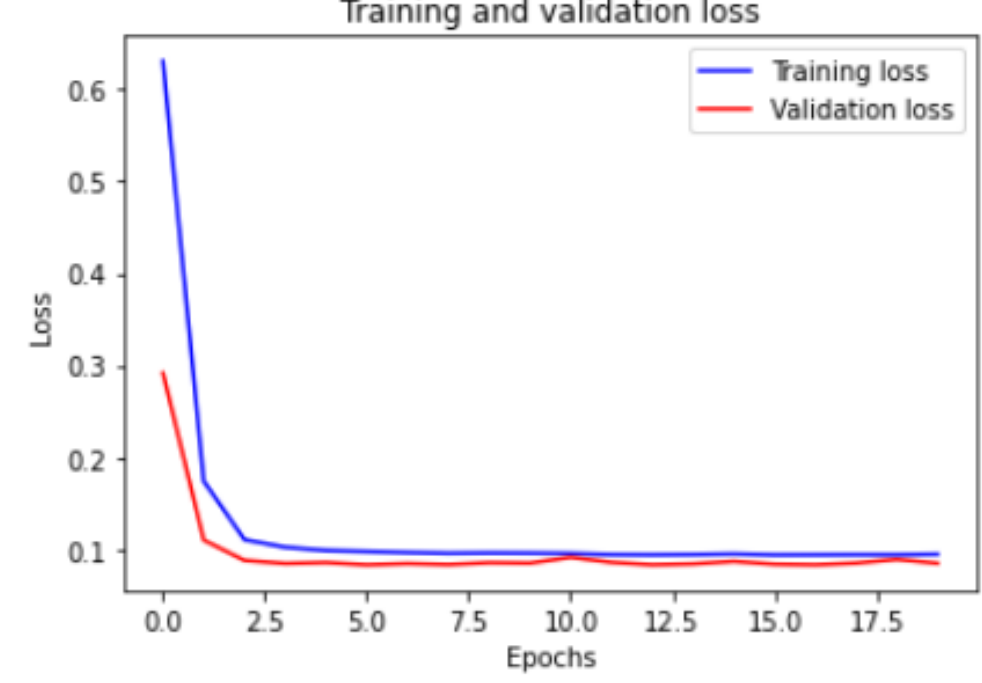
Figure 7. The training and validation loss through 20 epochs of the proposed ML-CNN model.